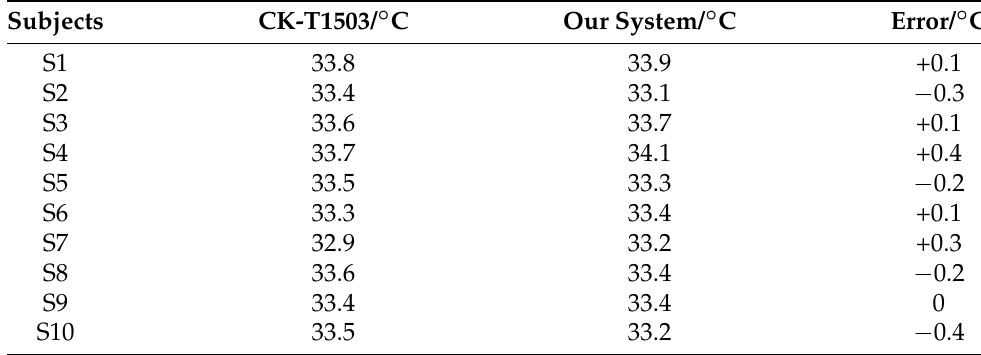
Table 2. Body surface temperature test results.